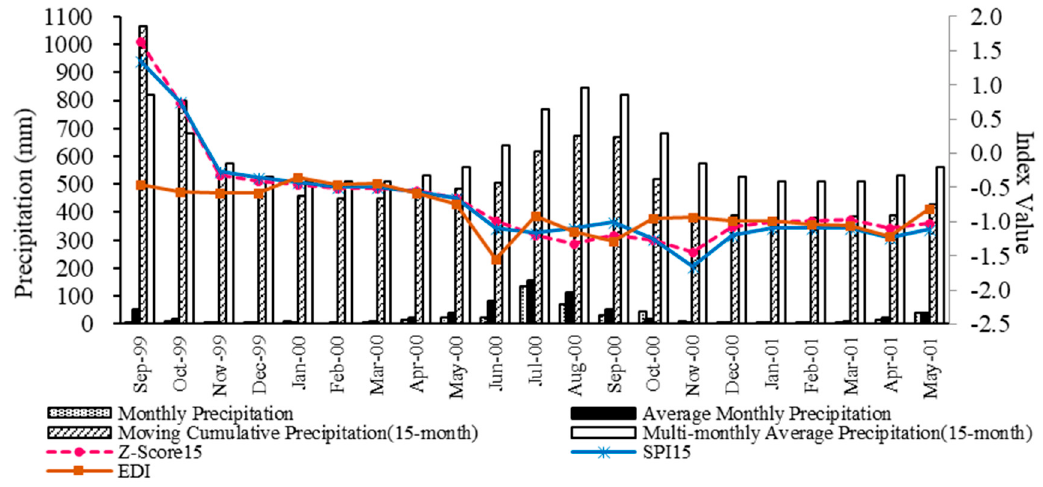
Figure 9. Changes of precipitation and drought indices for 15-month timestep in Keshan station from September 1999 to May 2001.